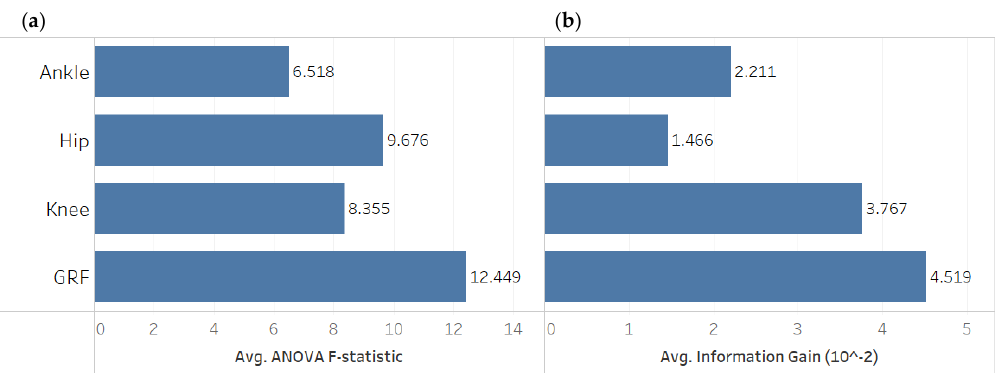
Figure 3. A comparison between gait feature sources in terms of ( a ) Average ANOVA F-statistic and ( b ) Average Information Gain. GRF features have higher F-statistic and information gain than the ankle, knee, and hip gait parameters.